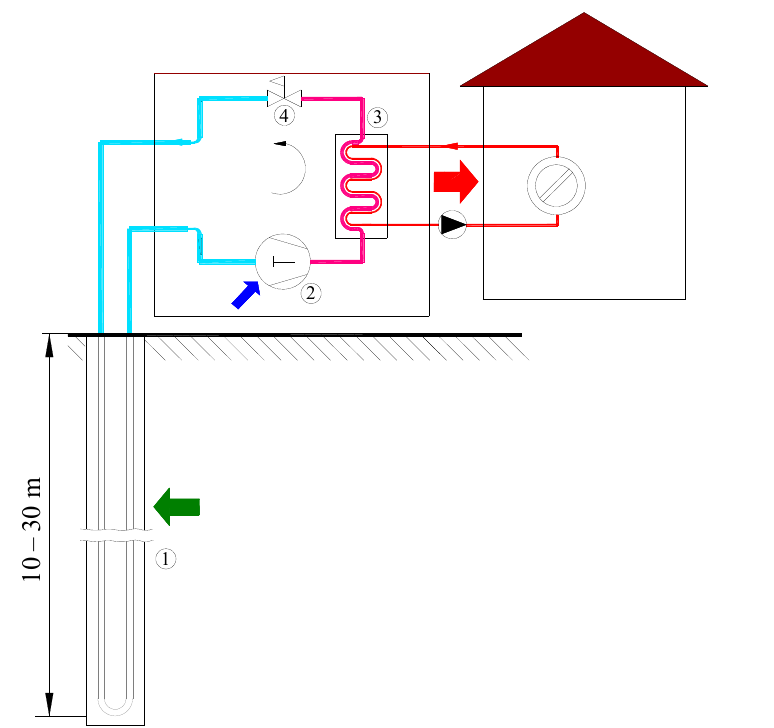
Figure 5. Direct expansion borehole heat exchanger (1—evaporator/BHE, 2—compressor, 3—condenser, 4—expansion valve).